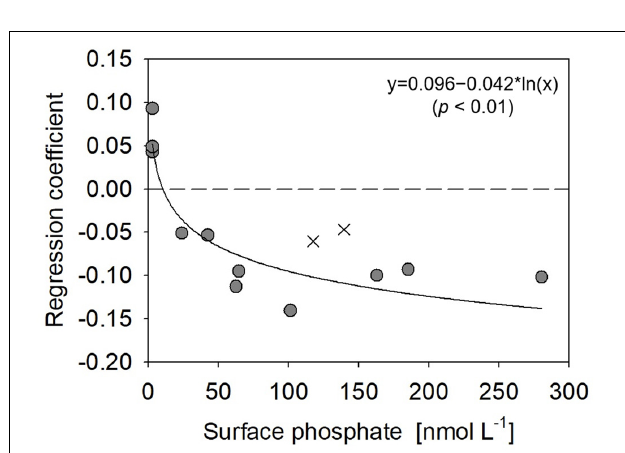
FIGURE 7 | Relationship between surface phosphate concentrations vs. regression coefficients derived between monoester concentrations and depths at stations 4–15. Filled circles represent the results obtained in this study, whereas crosses are those from Yamaguchi et al. (2019).